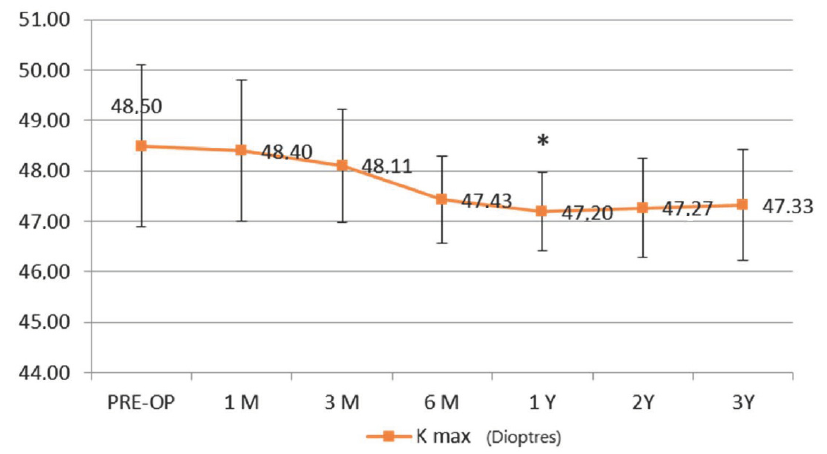
Figure 3. Maximum keratometry (K max). Topographic simulated maximum K reading (K Max) showed a progressive decrease starting at the third postoperative month and becoming statistically significant at one year follow-up ( Δ − 1.3 ± 0.78 D diopters), showing a stability during the entire follow-up. The coma value showed a statistically significant improvement at the sixth month ( Δ − 0.54 µm ± 0.2), continuing thereafter (Figure 4).